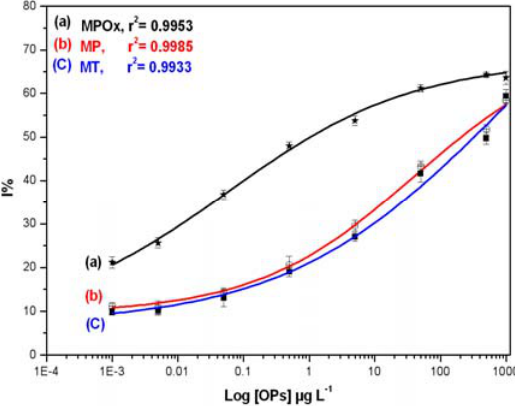
Figure 4. Inhibition profile obtained for (a) MPOx (b) MP and (c) MT spiked milk samples using 0.08 U BuChE. The assays were carried out in 384 well plate formats with 10 min incubation time.